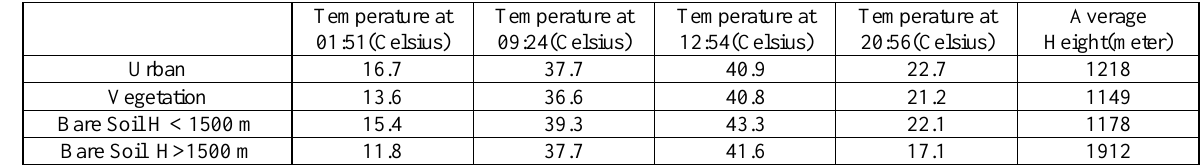
Table 1, LST changes of four classes in four times of the day and mean elevation of each